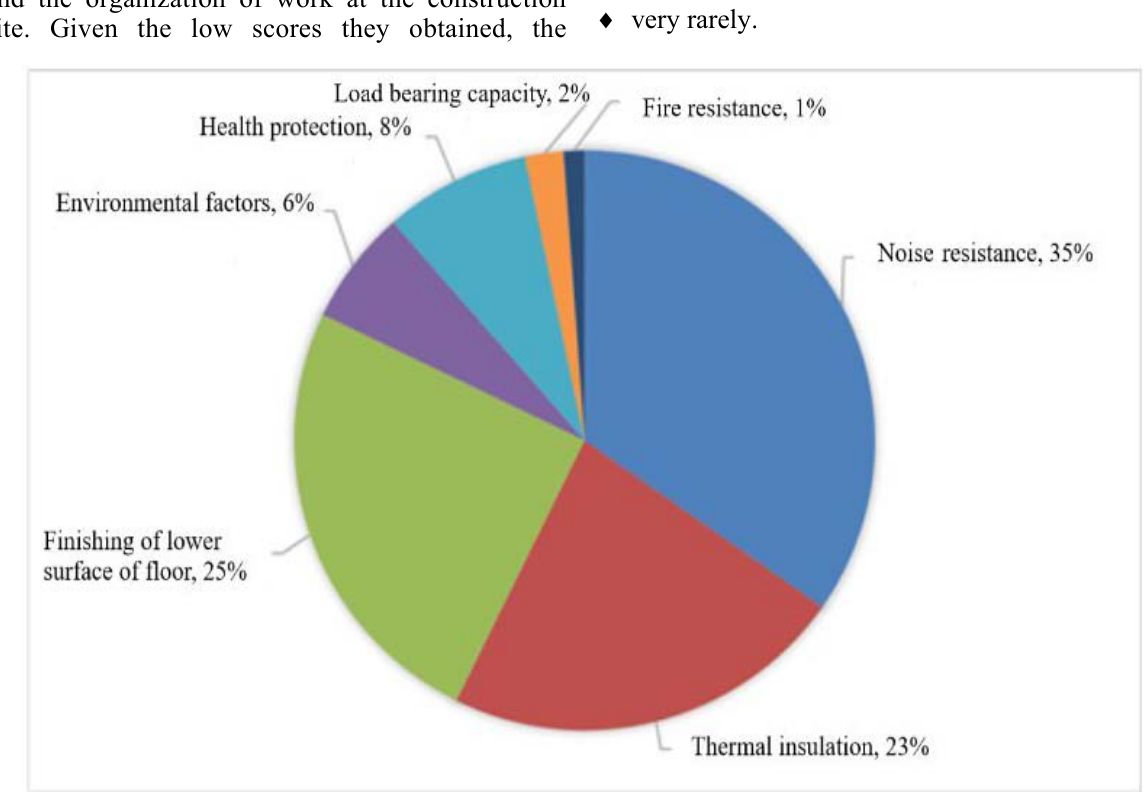
Fig. 3. Technical parameters instrumental to the selection of a given flooring system Source: Developed by the